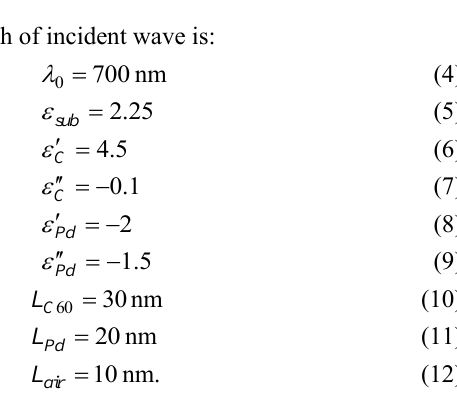
Figure 4. Normal incidence of plane electromagnetic wave (from the left) on the multinanolayer structure of overall thickness 300 nm located on a substrate of thickness 500nm. Distributions of permittivity  , amplitude of electric field E ˆ and power flow density P within and out of the structure is